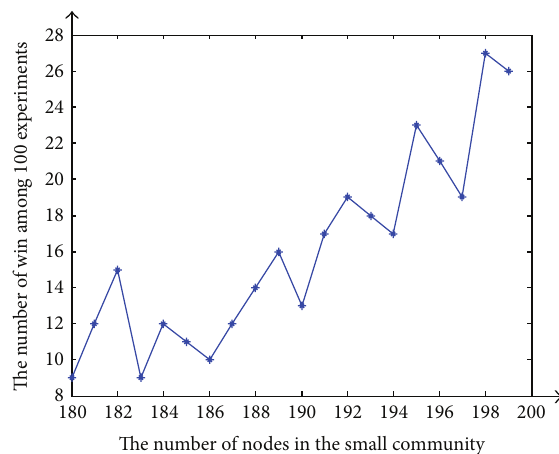
Figure 7: The Y-ray represents the number of win among 100 experiments. The X-ray represents the number of nodes in the small community. There is constant noise in the model.